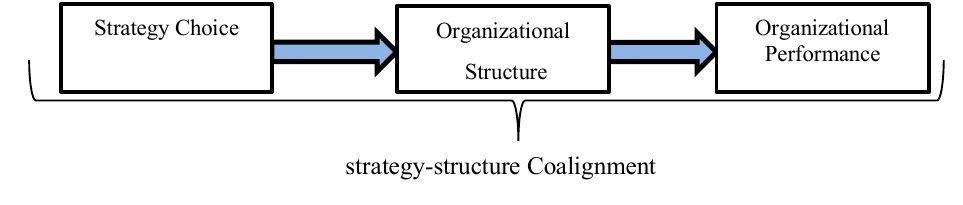
Figure 1: Organizational coalignment model Adapted from “Strategic Management in the Hospitality Industry”, by Olsen et al. (2008)